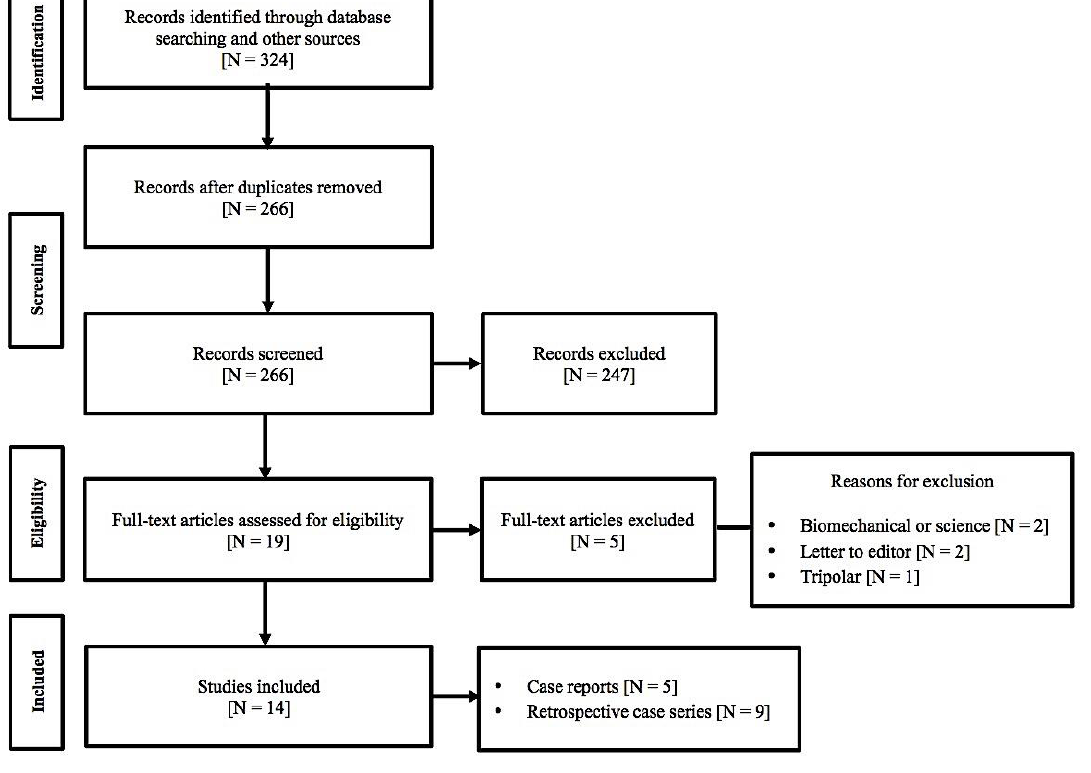
Figure 1. Flow chart showing our inclusion criterion.